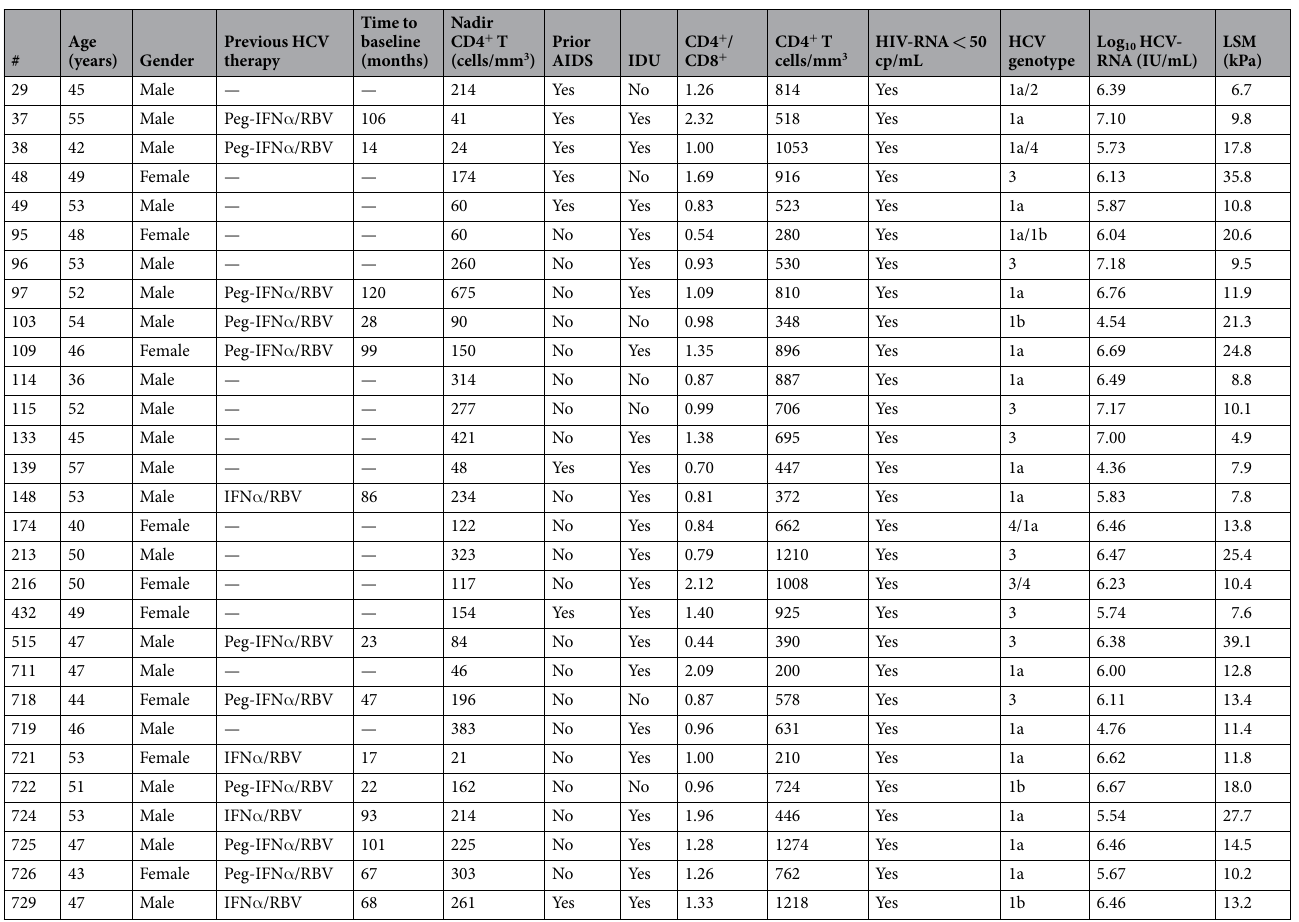
Table 1. Epidemiological and clinical characteristics at baseline of the HIV/HCV-coinfected patients included in the study. Abbreviations: AIDS, acquired immune deficiency syndrome; IDU, injecting drug user; HCV, hepatitis C virus; HCV-RNA, HCV plasma viral load; HIV, human immunodeficiency virus; HIV-RNA, HIV plasma viral load; LSM, liver stiffness measure; kPa, kilopascals; IFN α , interferon-alpha; peg-IFN α , PEGylated interferon-alpha; RBV,